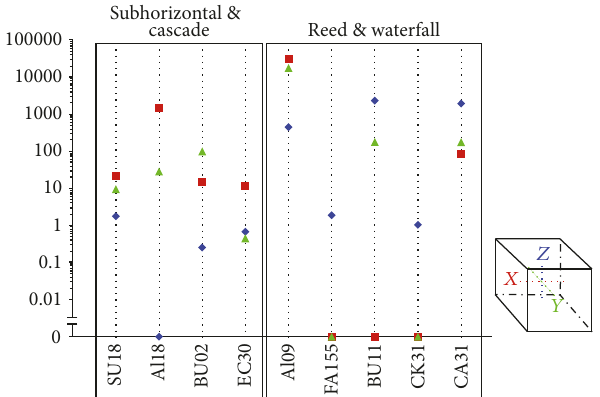
Figure 14: Simulated permeability 𝐾 sim ,𝑥 (red), 𝐾 sim ,𝑦 (green), and 𝐾 sim ,𝑧 (blue) for four subhorizontal and cascade samples and five reed and waterfall